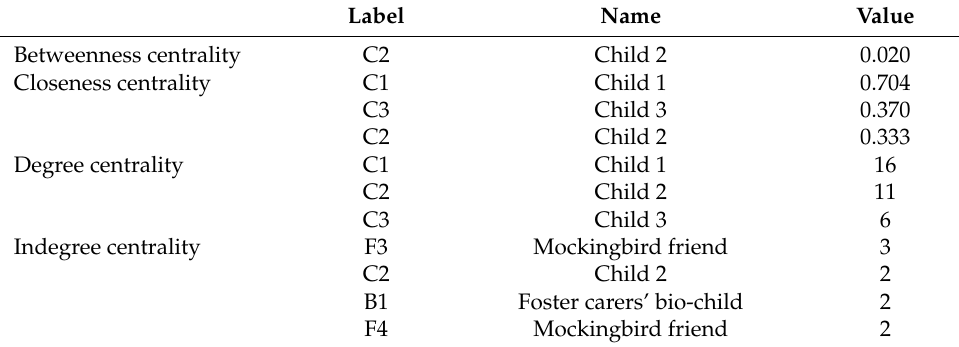
Table 1. Values on selected metrics.